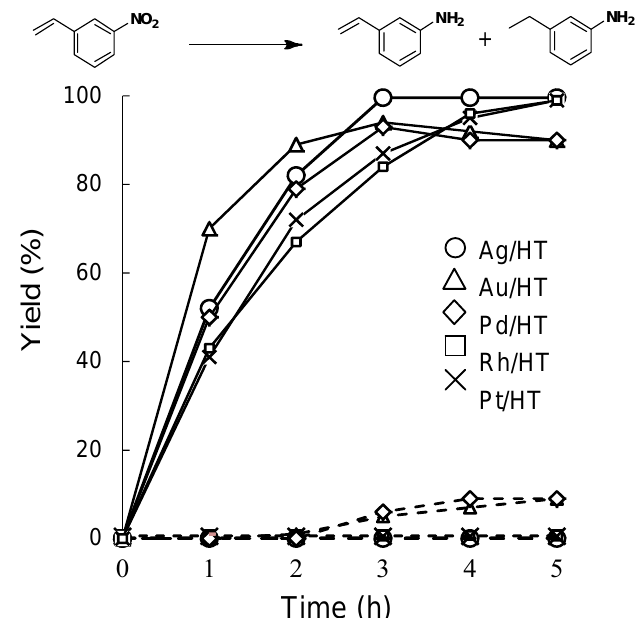
Figure 1. Kinetic Plots Showing the Yield of 3-Aminostyrene (solid lines) and 3- Ethylaniline (dashed lines) for the Reduction of 3-Nitrostyrene using HT-supported Metal Nanoparticles: Ag/HT, Au/HT, Pd/HT, Rh/HT and